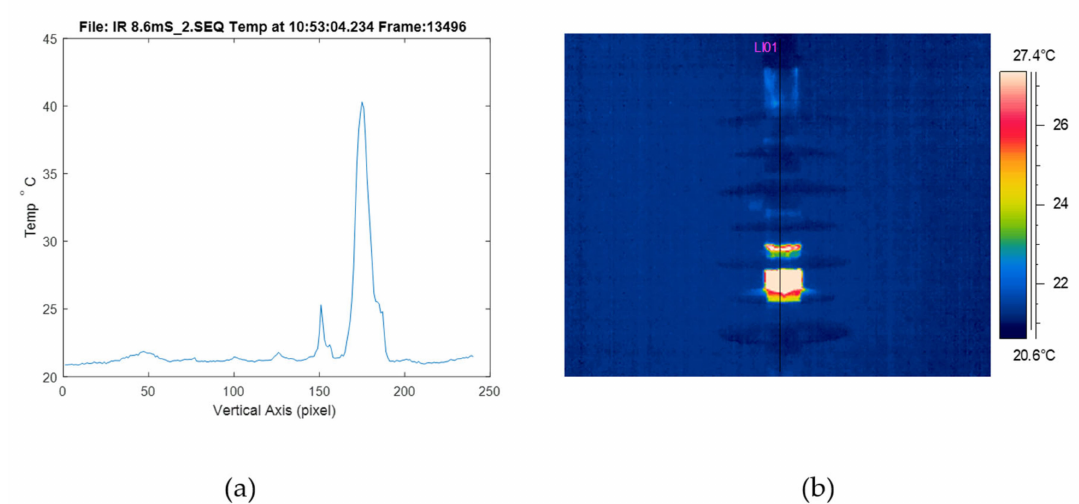
Figure 13. Dry-band onset and extension for heavy pollution ( a , b ) represent the (Dry-band Arcs) DBAs activity and corresponding temperature.